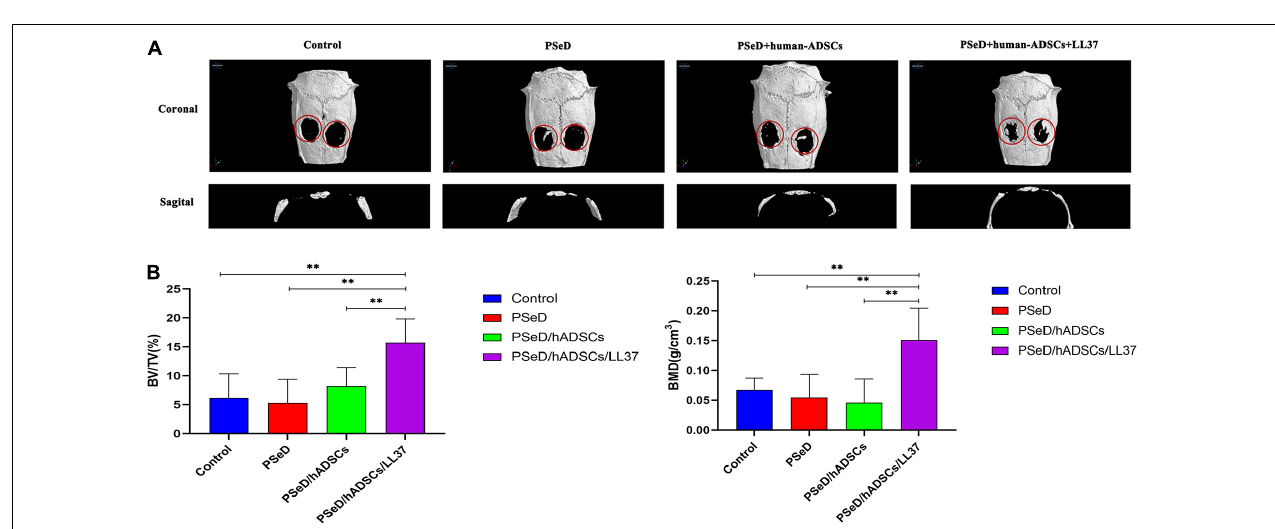
FIGURE 5 | Micro CT and analysis results of rat calvarial bone defect reconstruction. (A) Micro CT results: the reconstruction area increased from left to right: control group, PSeD group, PSeD/hADSCs group, PSeD/hADSCs/LL37 group. (B) Micro CT statistical analysis results: compared with the other three groups, the PSeD/hADSCs/LL37 group performed better in bone volume/tissue volume (BV/TV) ratio and bone mineral density (BMD) with significant differences ( n = 6, unpaired t -test, ∗∗ p <